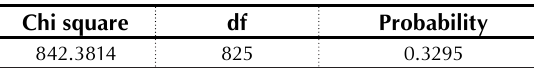
Table 5. White test results